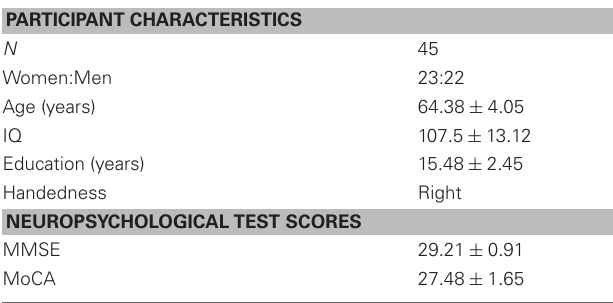
Table 1 | Older adult participant demographics and test means